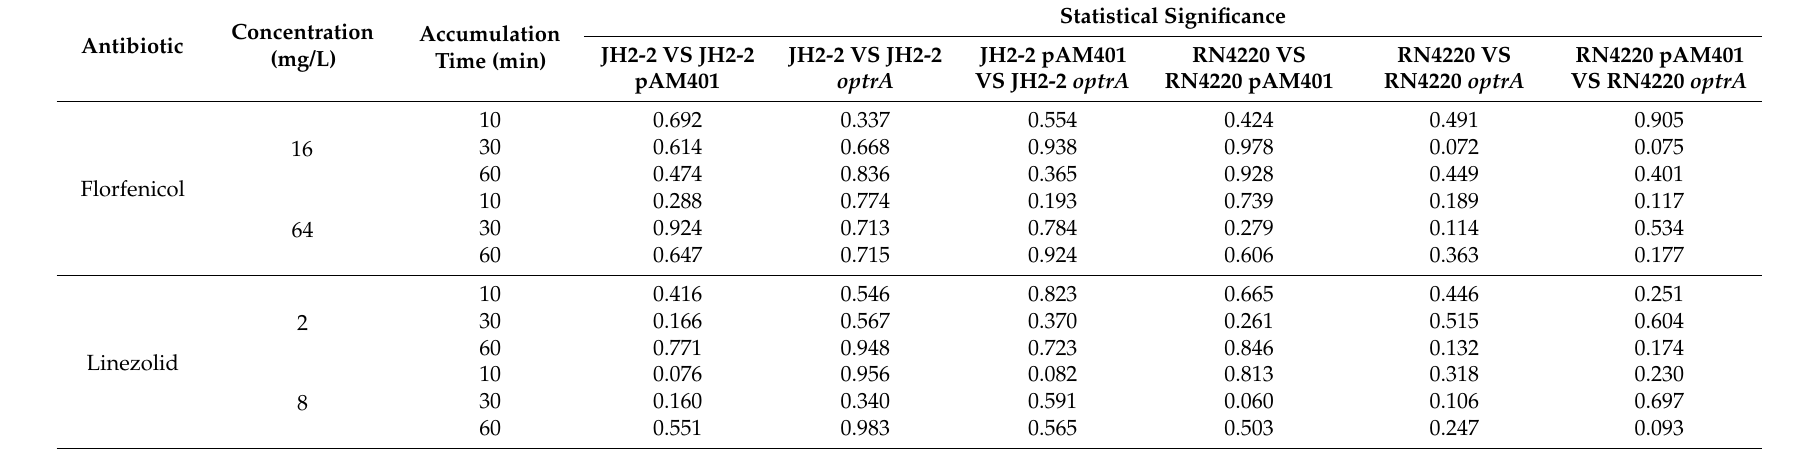
Table 2. P -values of one-way ANOVA of bacterial accumulation of florfenicol and